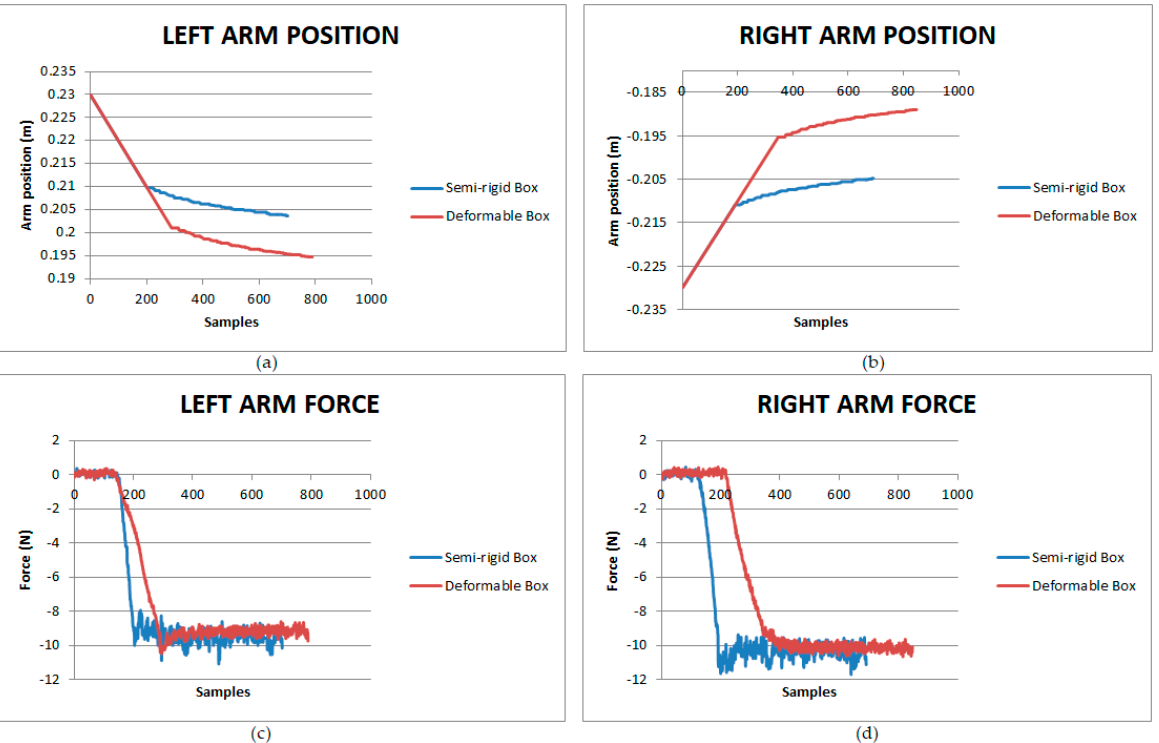
Figure 13. Lifting a semi-rigid box vs. lifting a deformable box. ( a , b ) Arms displacement to grasp the box. ( c , d ) Force needed to lift the box in each case.